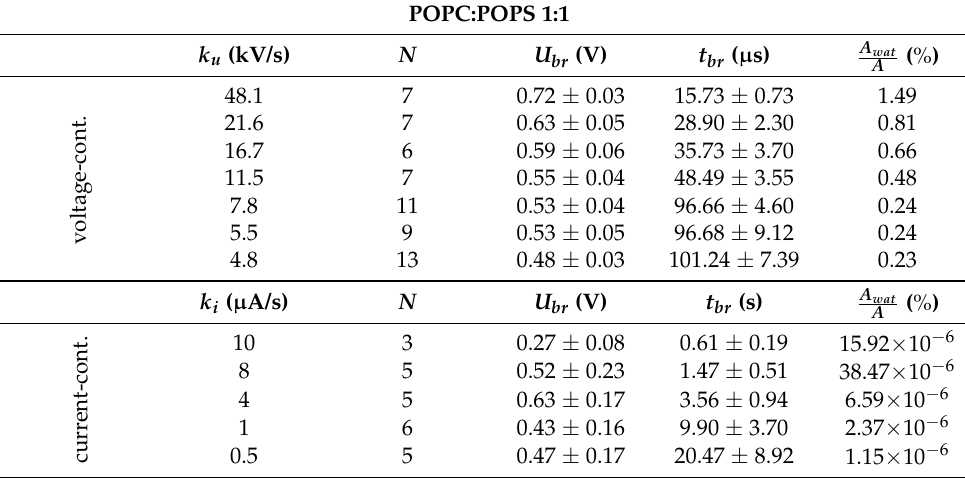
Table 4. Results for planar lipid bilayers composed of POPC:POPS. In the upper part of the table, the results of voltage-controlled measurements with seven different slopes k u are gathered while the results of current-controlled measurements with five different slopes k i are presented in the lower part of the table. For each slope of linearly rising signal, the planar lipid breakdown voltage U br and lifetime t br are presented. Values are given as means ± standard deviations. A wat fraction of the planar lipid bilayer that is occupied by pores. N is the number of experiments in each experimental